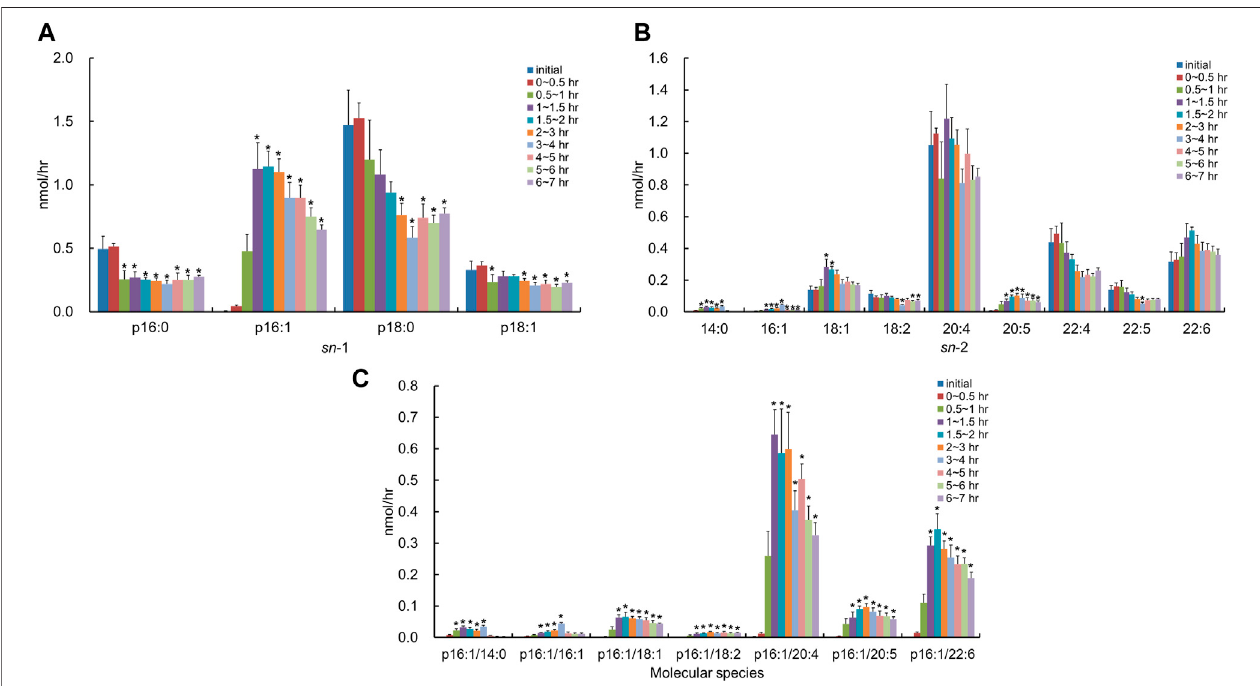
FIGURE4| Changeinmolecularspeciesduetotheclassi fi cationin (A) thehydrocarbonchainatthe sn -1positionand (B) FAatthe sn -2positionand (C) changein molecular species withp16:1 at the sn -1 position, in lymphatic PlsEtn of thoracic lymph-cannulated rats for 7 h after duodenaladministration ofthe emulsion containing the lipid extracted from S. ruminantium . Data are represented as mean ± SEM ( n = 5 – 6). Asterisk indicates signi fi cant difference with respect to the values at time 0 ( p < 0.05).